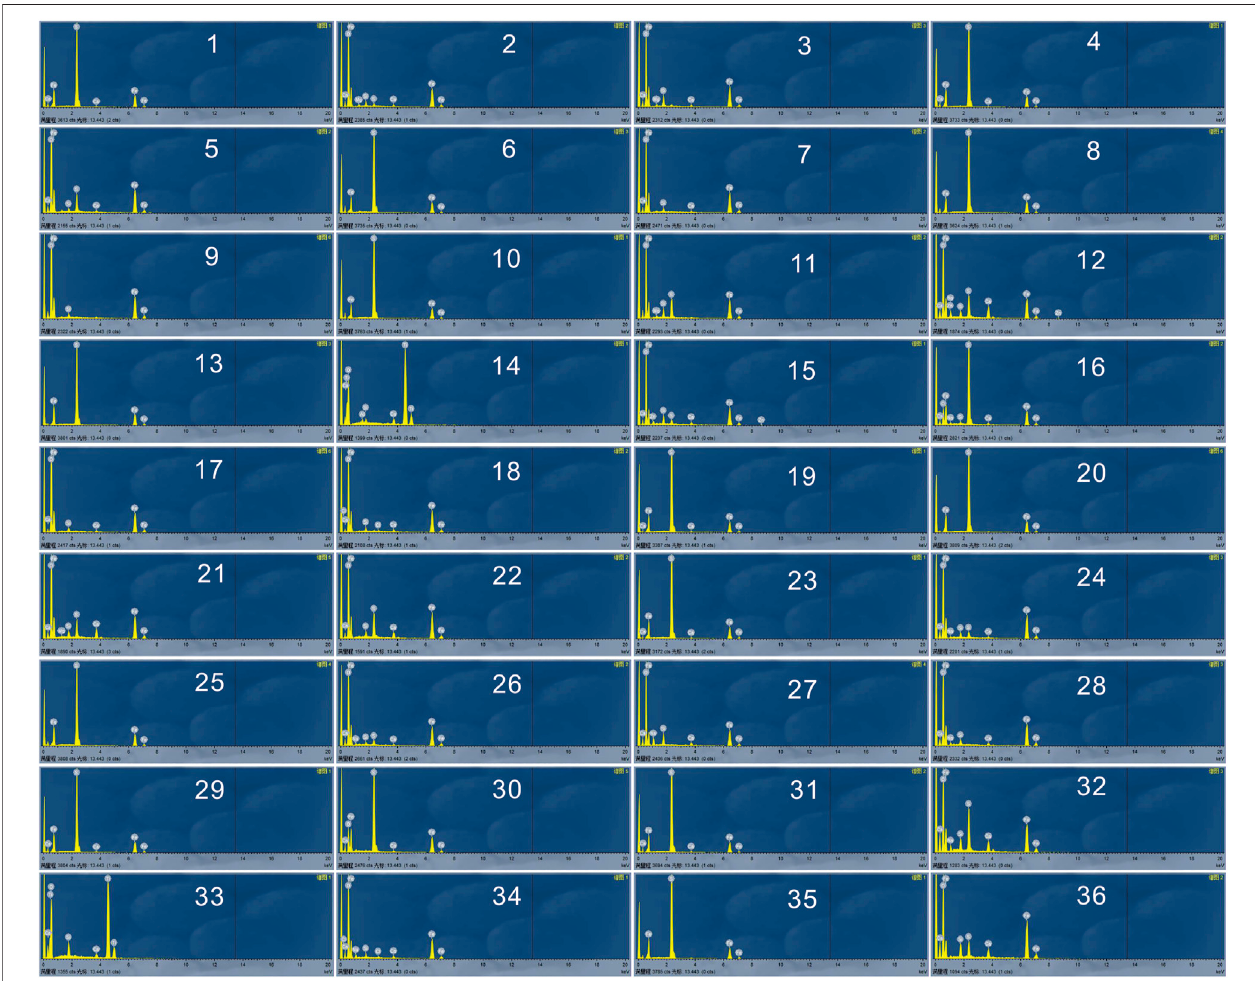
FIGURE 4 | Energy dispersive spectroscopy images of representative